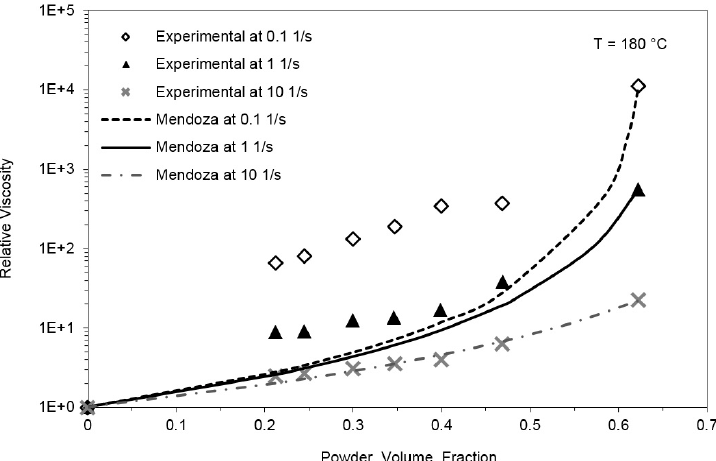
Figure 7. Relative viscosity as a function of powder loading for POM ‐ based feedstock at 180 °C. Lines represent the fittings done by the model proposed by Mendoza and Santamaria ‐ Holek at different shear rates. Please note that the vertical axis is in logarithmic scale.